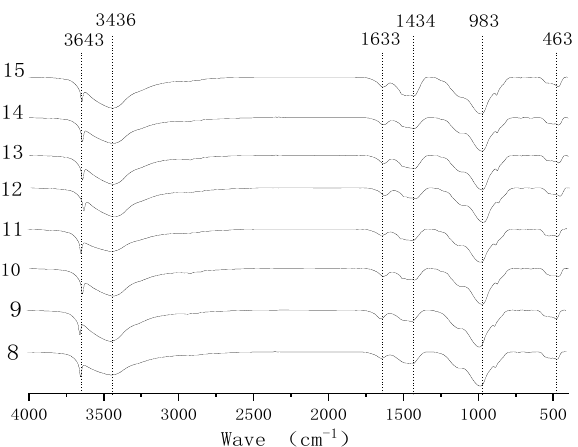
Figure 5. FTIR analysis of EPS concrete in groups 8–15.